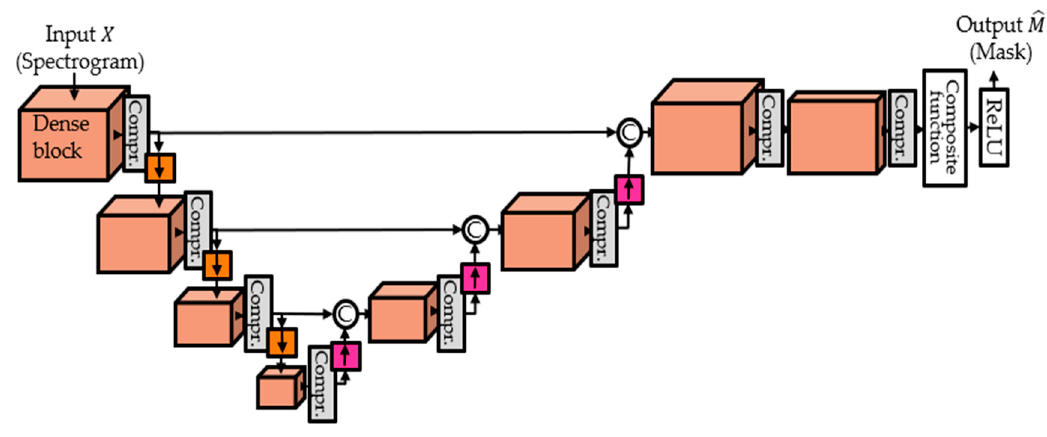
Figure 4. MDenseNet